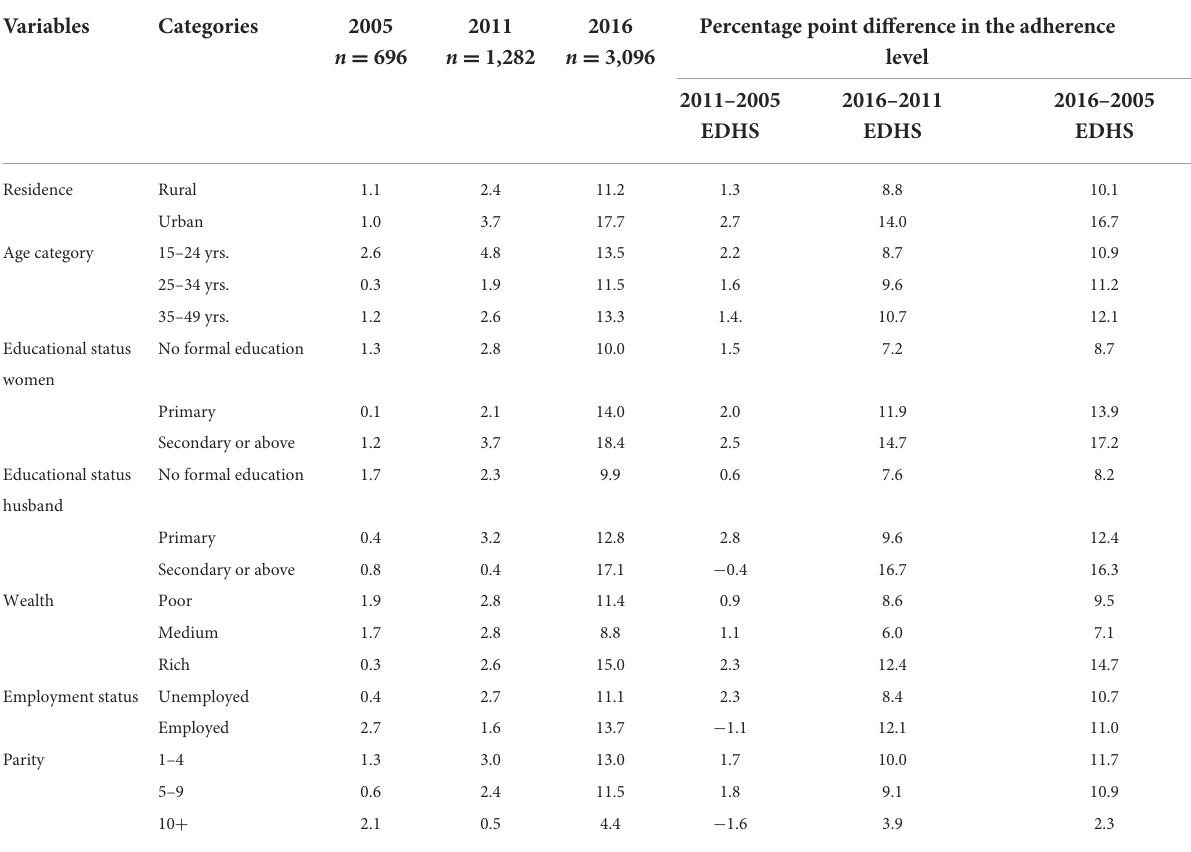
TABLE 3 Proportion of adherence levels to iron supplements based on the sociodemographic and socioeconomic characteristics of the respondents in Ethiopia (EDHS 2005–2016).